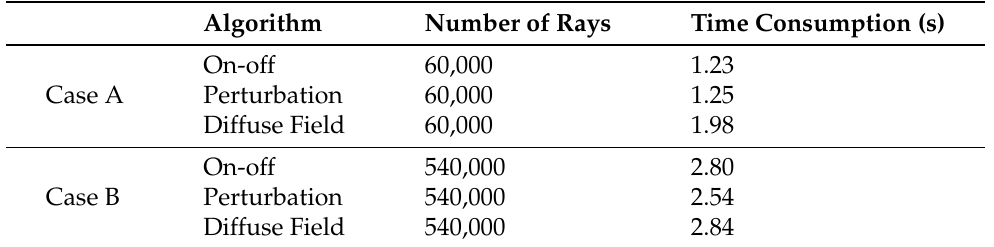
Figure 7. The maximum simulation error in T 20 ( a , b ) and C 50 ( c , d ) as it varies for different numbers of rays in the simulation. A limit of 1 JND, as estimated from the measurements, is included in the graph. As expected, the simulation error decreases as the number of rays increase. This decrease is faster for case A. Table 4. The number of rays needed for the e Sim to be below 1 JND for all the examined room acoustic parameters and the time consumption for such a simulation. More rays are needed for all algorithms in Case